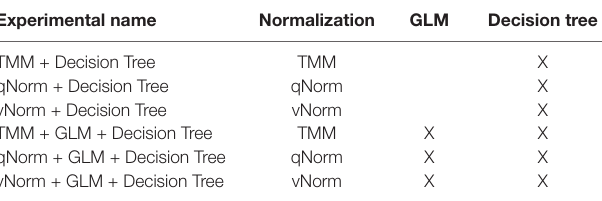
TABLE 2 | Machine learning experimental approach using decision